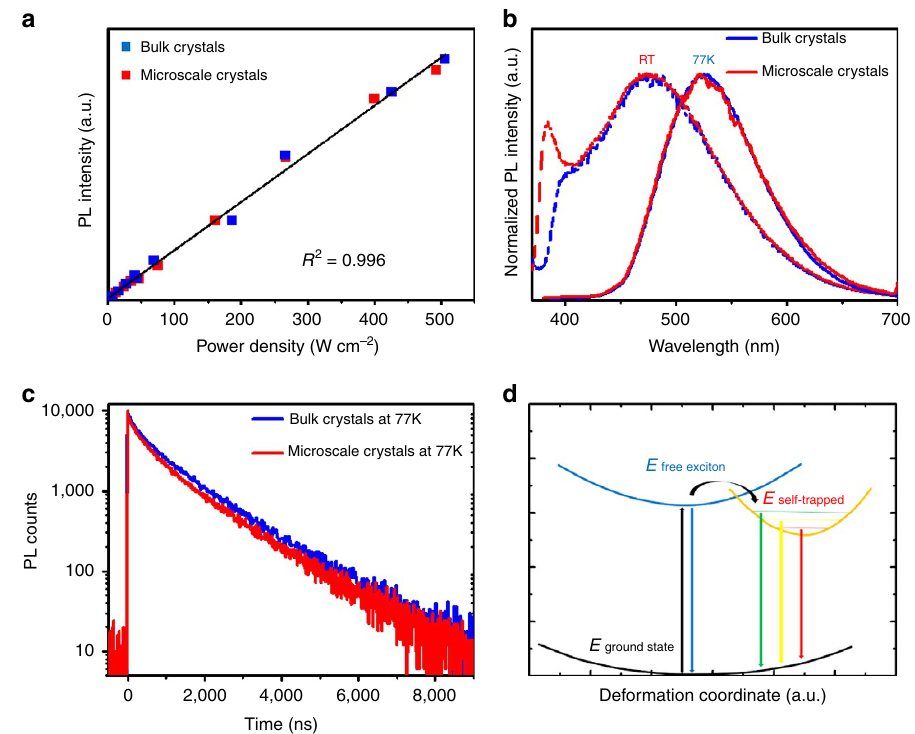
Figure 3 | Verification of the photoluminescence mechanism of exciton self-trapping in 1D perovskites. ( a ) PL intensity versus excitation power for both the bulk and microscale 1D perovskite crystals at room temperature. ( b ) Emissions of the bulk and microscale 1D perovskite crystals (excited at 360nm) at room temperature (dash lines) and 77K (solid lines). ( c ) Luminescence decays of the bulk and microscale 1D perovskite crystals at 77K (measured at 525nm). ( d ) Configuration coordinate diagram for the coexisting of free and self-trapped excitons in 1D perovskites; the straight and curved arrows represent optical and relaxation transitions,